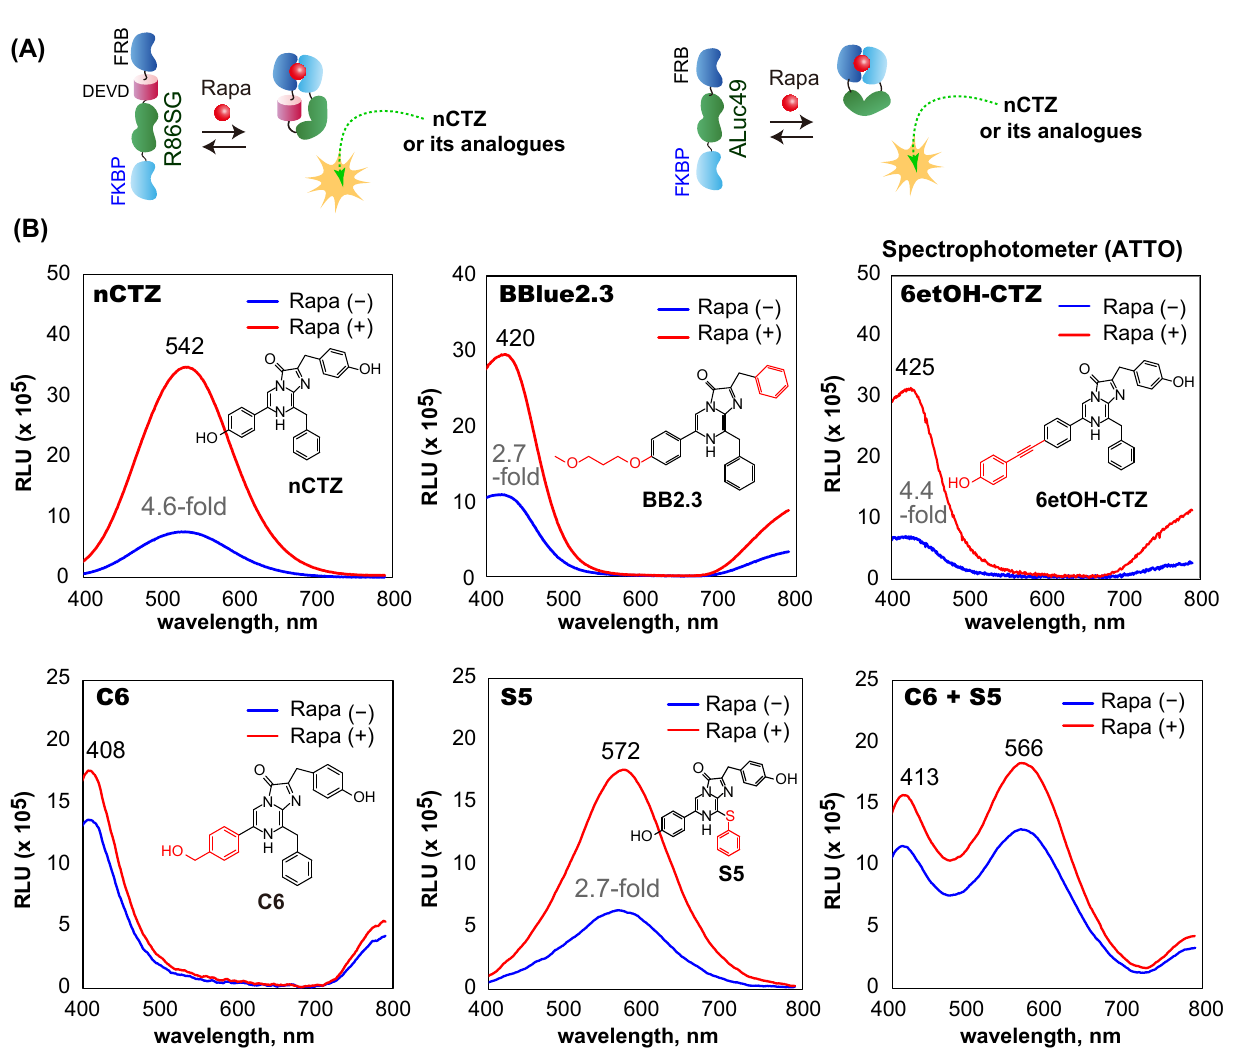
Figure 4. ( A ) The putative working mechanism of F-R86SG v3 -F and F-A49 v4 -F in the presence of rapamycin. ( B ) BL spectra of cells coexpressing F-R86SG v3 -F and F-A49 v4 -F according to various CTZ analogues. The BL spectra of COS-7 cells containing F-R86SG v3 -F and F-A49 v4 -F were determined